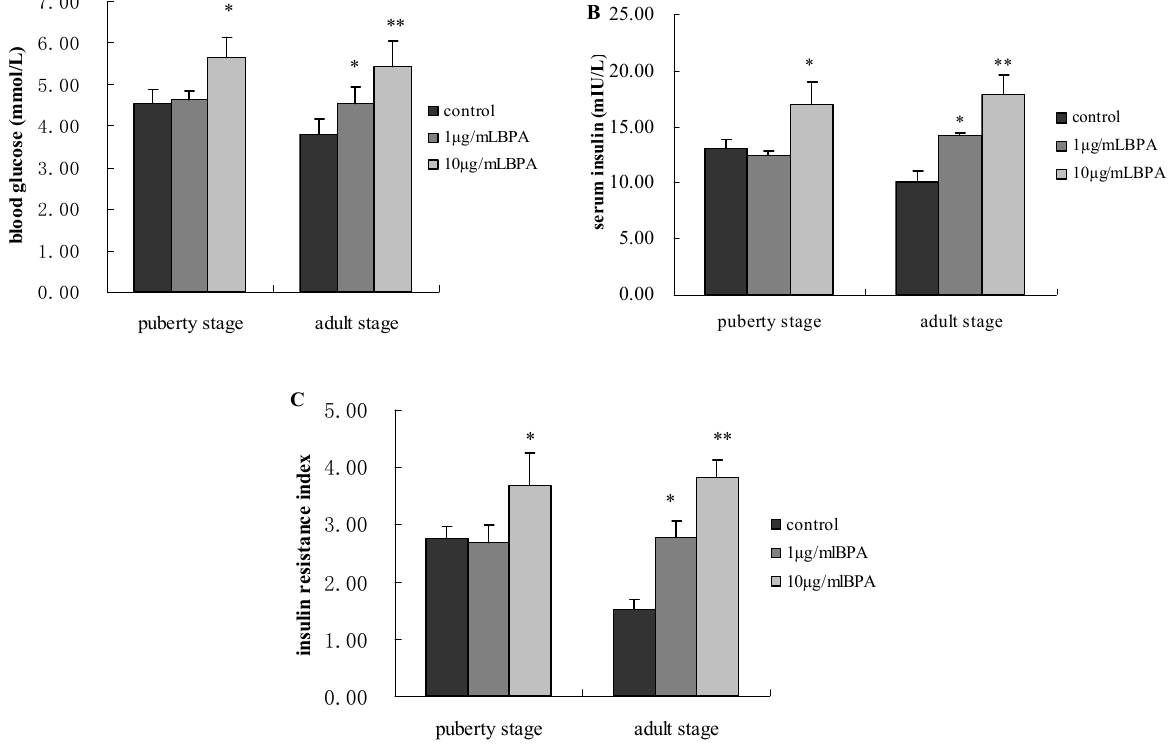
Figure 2. Effects of perinatal exposure to BPA on glucose metabolism of male offspring at their puberty stage and adult stage. Pregnant rats ( n = 7/group) were exposed to vehicle or BPA in water at levels of 1 or 10 µg/mL from gestation day 6 through the end of lactation. Serum glucose level was measured by using a glucometer (OneTouch Ultra). Serum insulin concentration was measured by insulin radioimmunoassay kits. HOMA-IR = fasting insulin ( μ IU/mL) × glucose (mmol/L)/22.5. Values represent the mean ± SE ( n = 7, one from each group). * p < 0.05 and ** p < 0.01 compared with